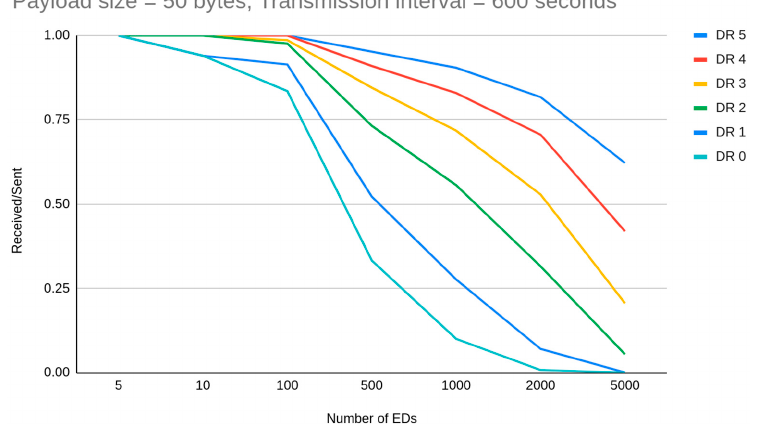
Figure 5. DR allocation can further downgrade the capacity by decreasing transmission interval and increasing payload size.